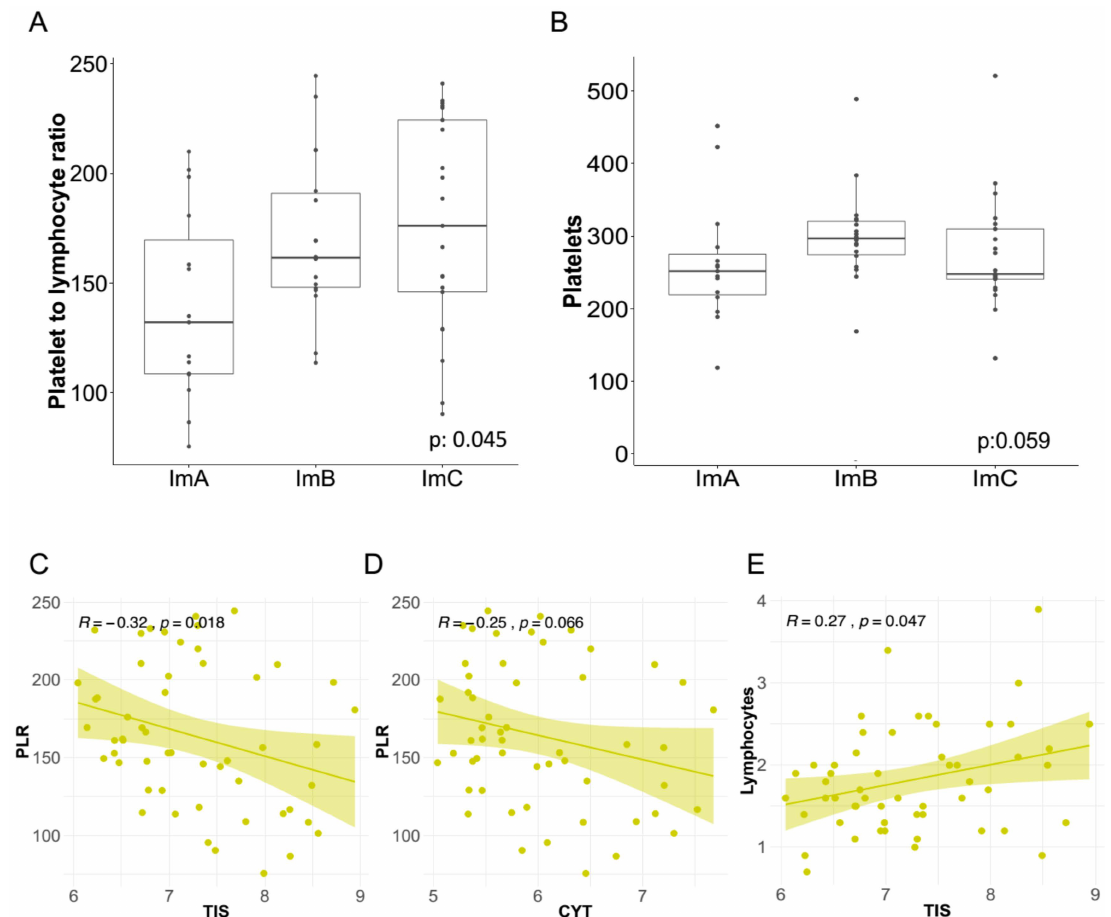
Figure 4. Correlation of local immune features and the inflammatory systemic blood markers in the triple negative breast cancer cases. Distribution of ( A ) platelet-to-lymphocyte ratio (PLR) and ( B ) platelets acquired through blood sample test in the Im-Clus. Scatter plots showing the correlation of: ( C ) Tumor Inflammation Signature (TIS) vs. PLR, ( D ) CYT vs. PLR, and ( E ) TIS vs. lymphocytes. All R coe ffi cients measured by Spearman method. Statistical comparison based on Kruskal-Wallis